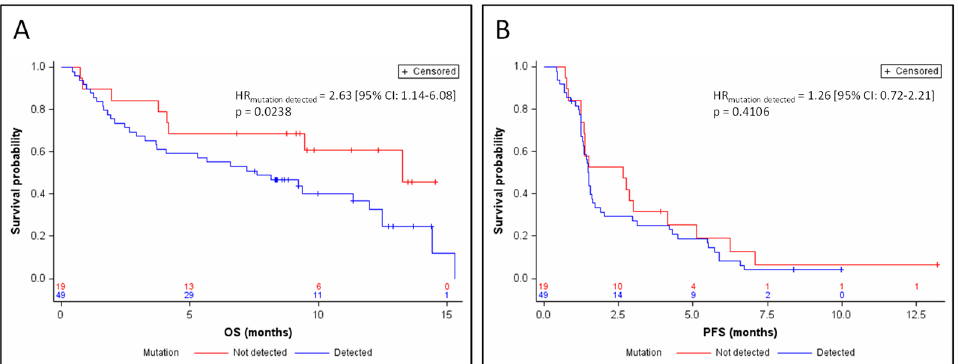
Figure 1. Kaplan–Meier estimates of overall survival (OS) ( A ) and progression-free survival (PSF) ( B ), depending on the detection of ctDNA. HR, hazard ratio.